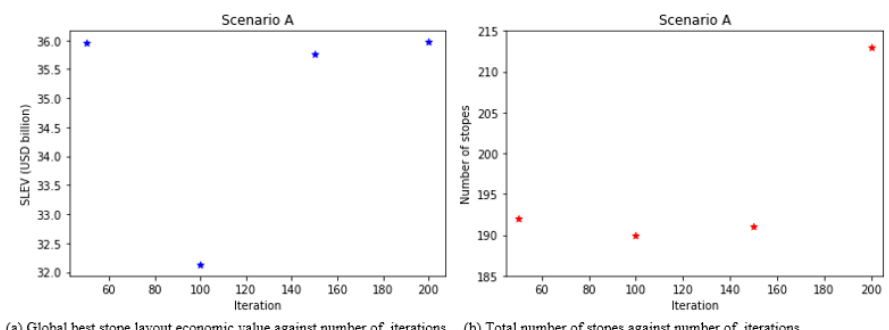
Figure 9. Scenario A: optimisation results of SLEV and number of stopes.